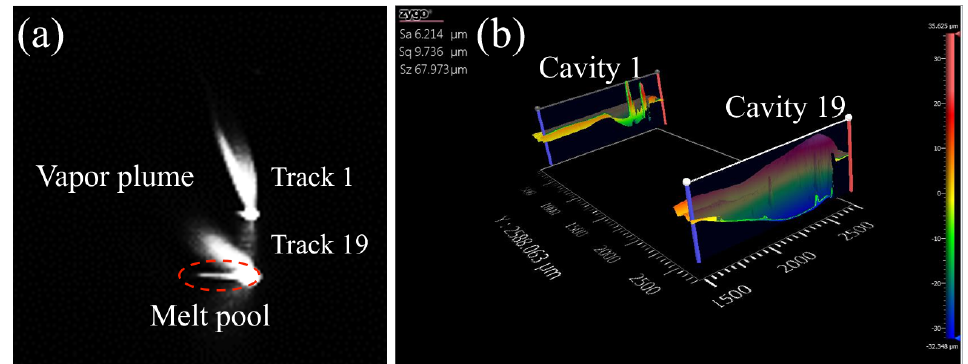
Figure 7. Comparison of plume behavior and track tail cavities before and after melting mode transition. ( a ) Superimposition of the last frame captured before laser-off in Track 1 and 19 at 300 W 600 mm/s, the elongated melt pool is highlight in the red dashed ellipse. ( b ) Anatomy of the resultant solidified track tail cavities of Track 1 and